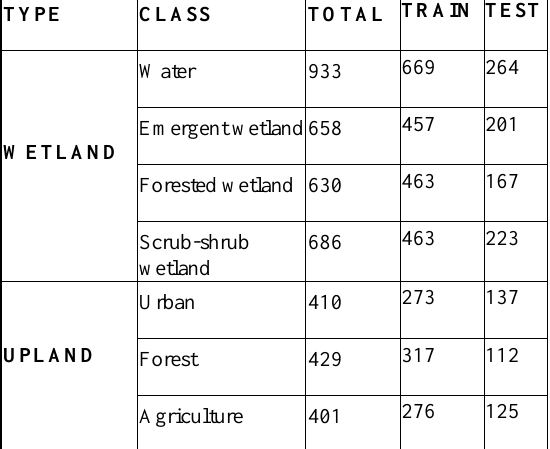
Table 1. Wetland and upland test and train